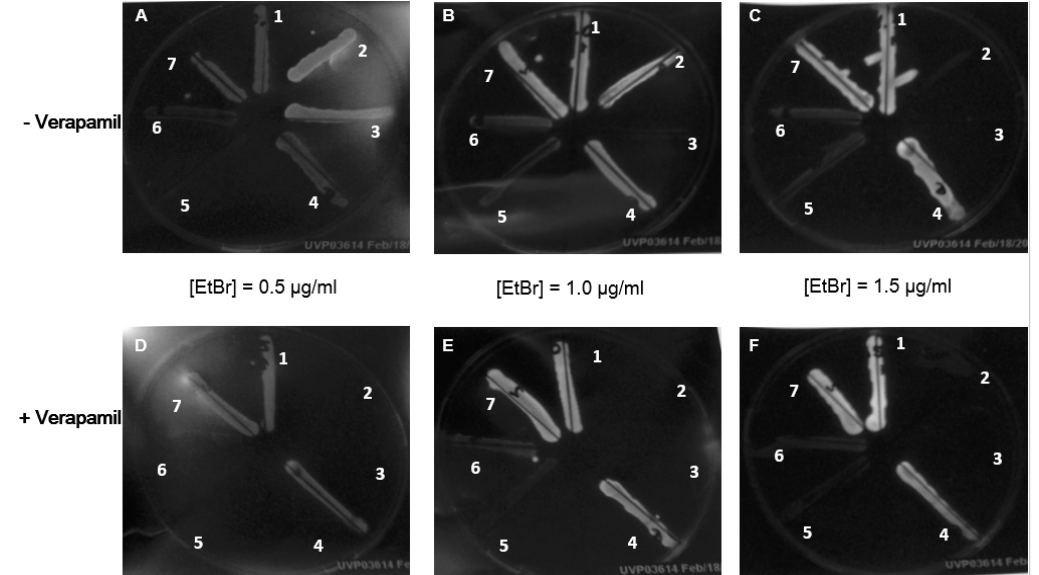
Figure 2. Evaluation of efflux pump activity based on bacterial cultures growing on ethidium bromide agar plates (cartwheel method). Cultures were swabbed on Müller Hinton blood plates containing increasing concentrations of ethidium bromide (0.5–1.5 µg/mL) without ( A – C ) and with ( D – F ) the addition of 200 µg/mL verapamil. Fluorescence was detected under UV light after 16 h of incubation at 35 °C. 1: E. coli ATCC 25922, 2: MRSA NCTC 10442, 3: S. aureus ATCC 25923, 4: B. cepacia ATCC 25414,